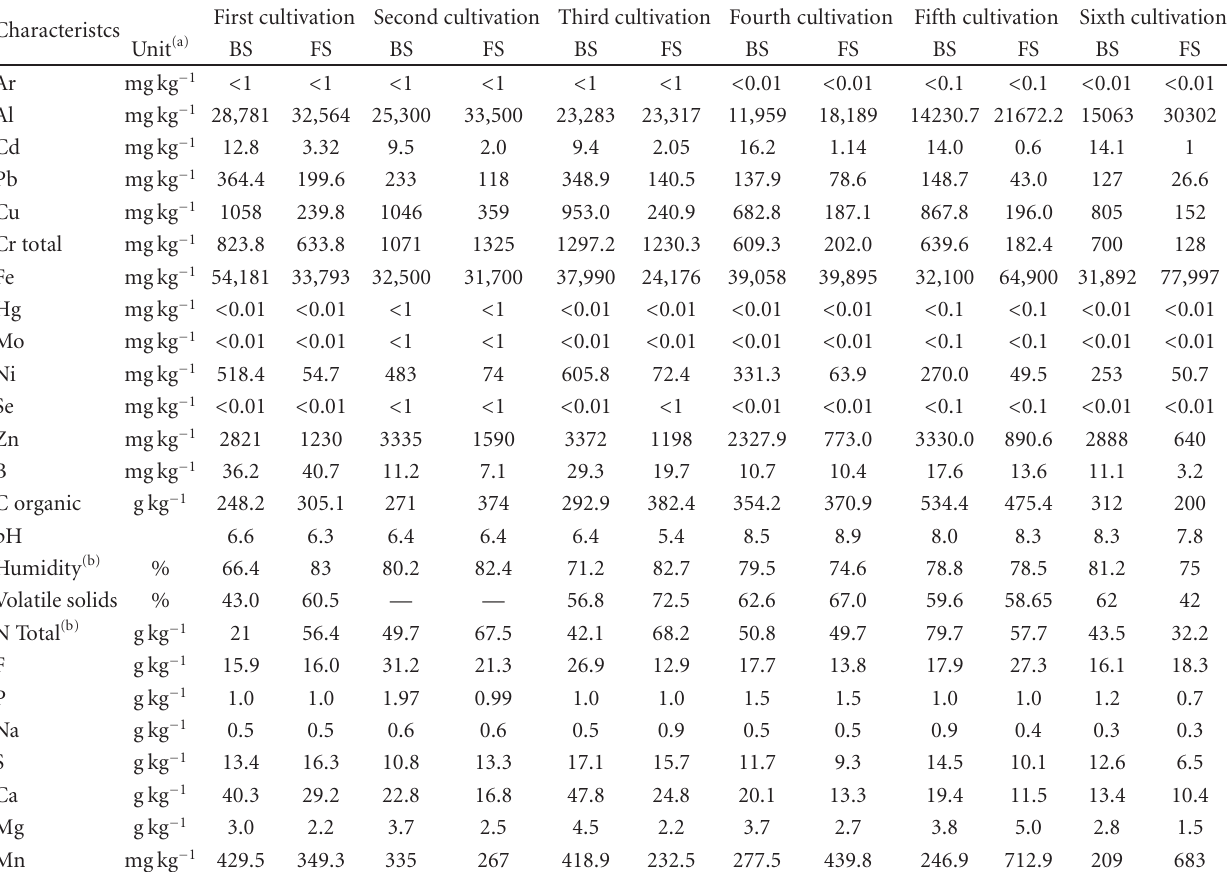
Table 1: Chemical characteristics of sewage sludge utilized in